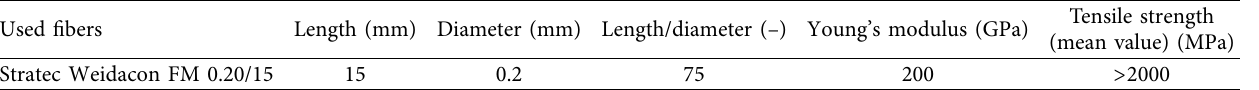
Table 2: Main properties of the used steel fibers (producer’s data sheet).